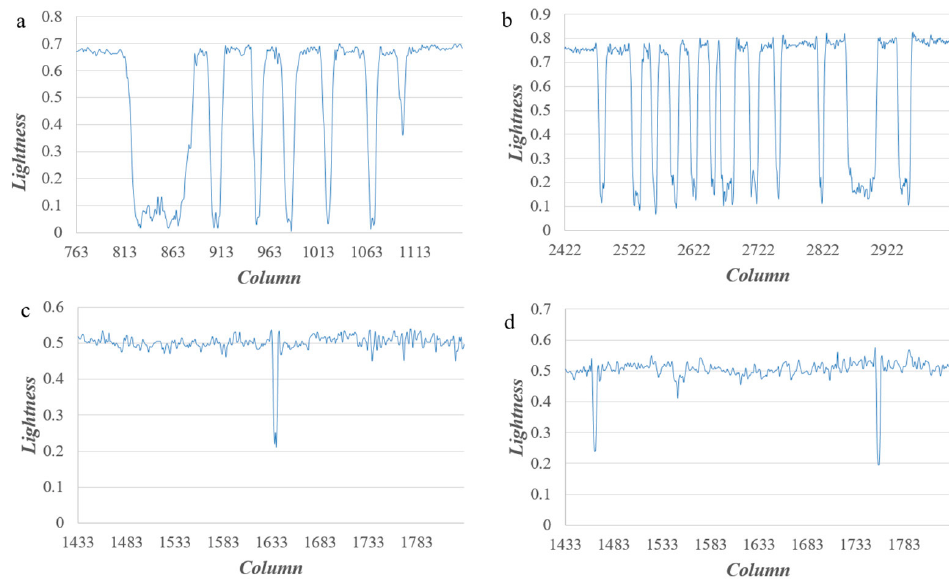
Figure 2. Intensity (Lightness) profiles.